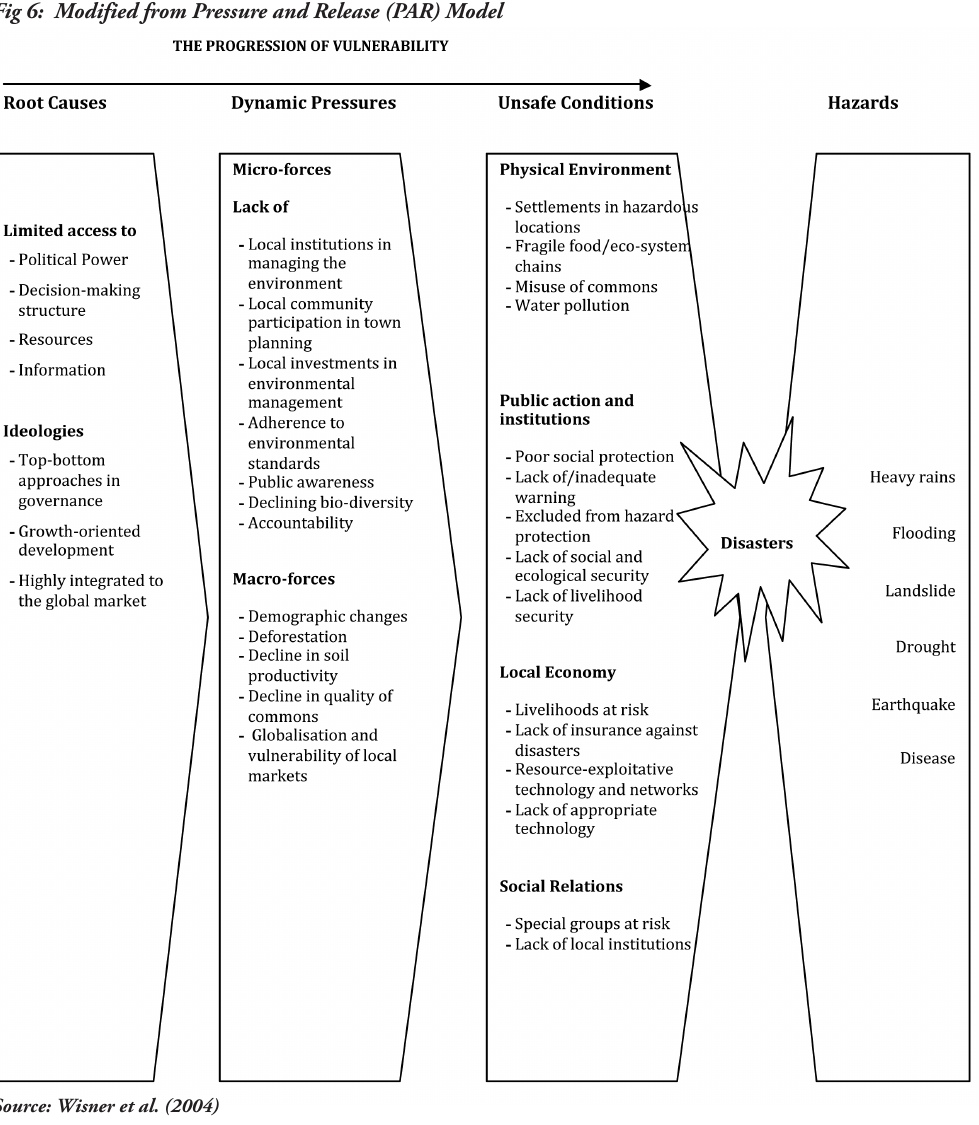
Source: Wisner et al. (2004)